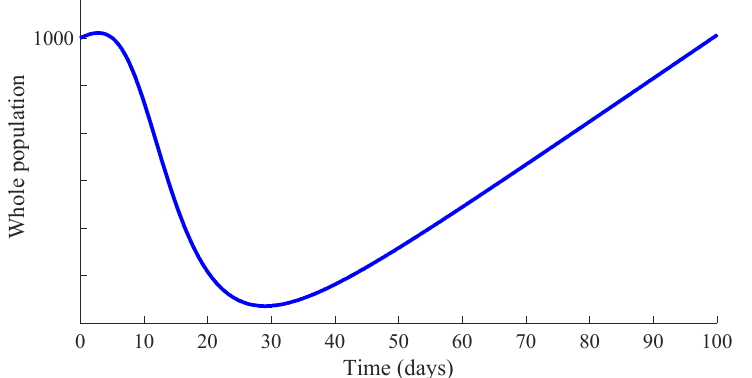
Figure 4. Time evolution of the whole population in the SIRS model with vaccination and treatment within the 100 first days.